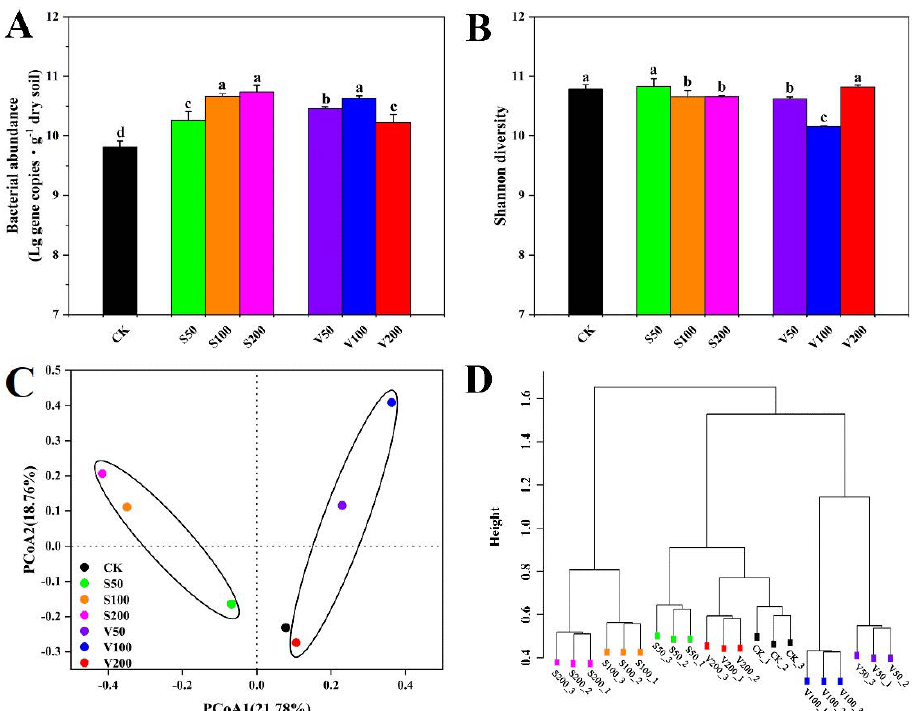
Figure 1. Effects of organic ameliorants on compositional and structural diversities of soil bacterial community. ( A ) Soil bacterial abundance; ( B ) Shannon diversity of bacterial community; ( C , D ) PCoA and hierarchical cluster analysis of bacterial communities in different soils, respectively. Different letters on bars represent significantly different at p < 0.05 according to Duncan’s multiple-range test.